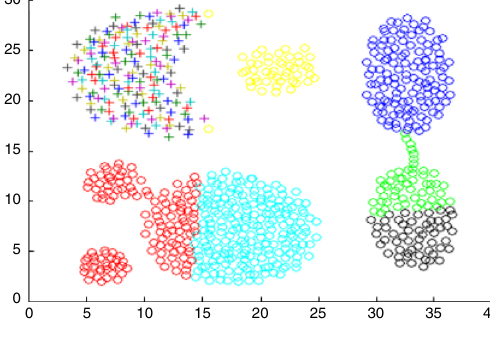
Figure 8. Result of K -means on “ Aggregation ”